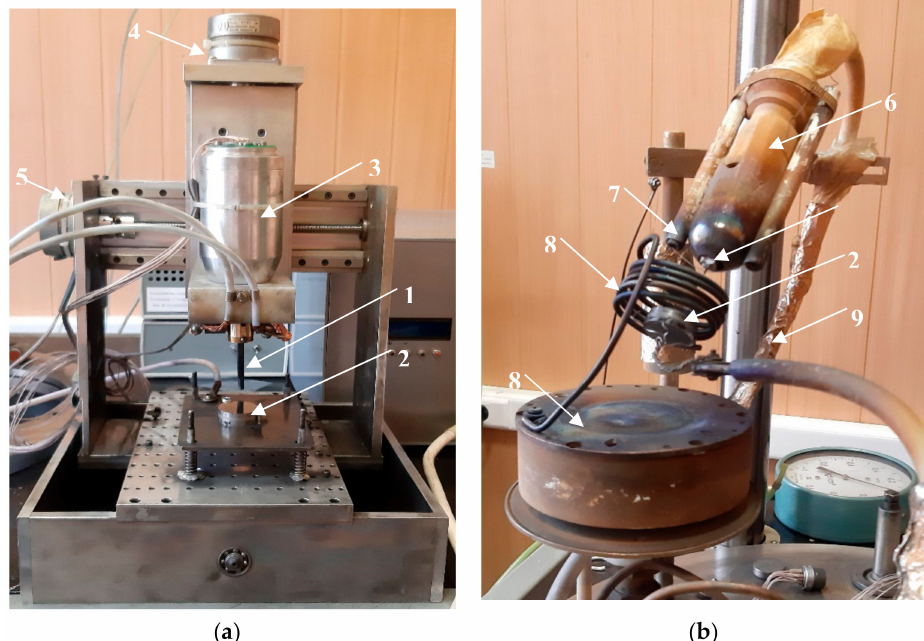
Figure 1. Appearance of blocks for vacuum electro-spark alloying (VESA) ( a ) and pulsed cathodic